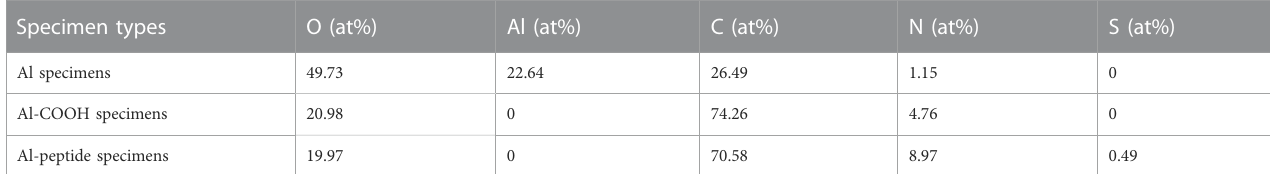
TABLE 1 XPS semi-quantitative analysis of different